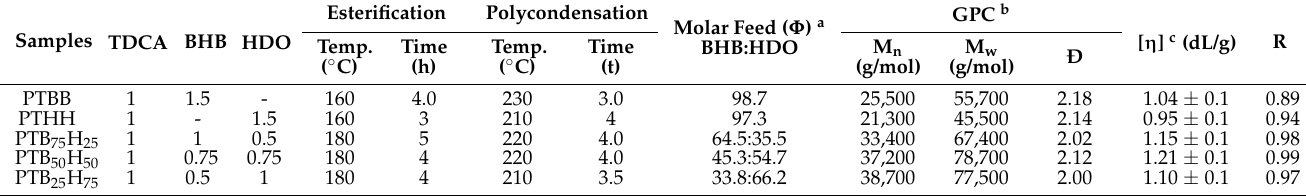
Table 1. Feeding ratio, reaction condition, molecular weight (M w and M n ) and polydispersity index (Ð), intrinsic viscosity [ η ], and degree of randomness (R) of the copolyesters. Samples TDCA BHB